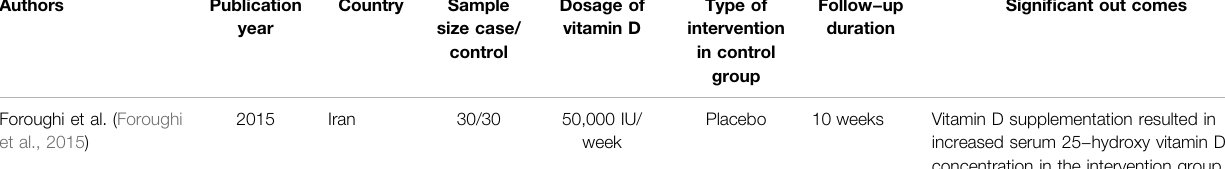
concentration in the intervention group compared to the control group. Intake of vitamin D supplements led to a marginally signi fi cant decrease in fasting blood glucose in the intervention group compared to the control group. HOMA − IR decreased in the